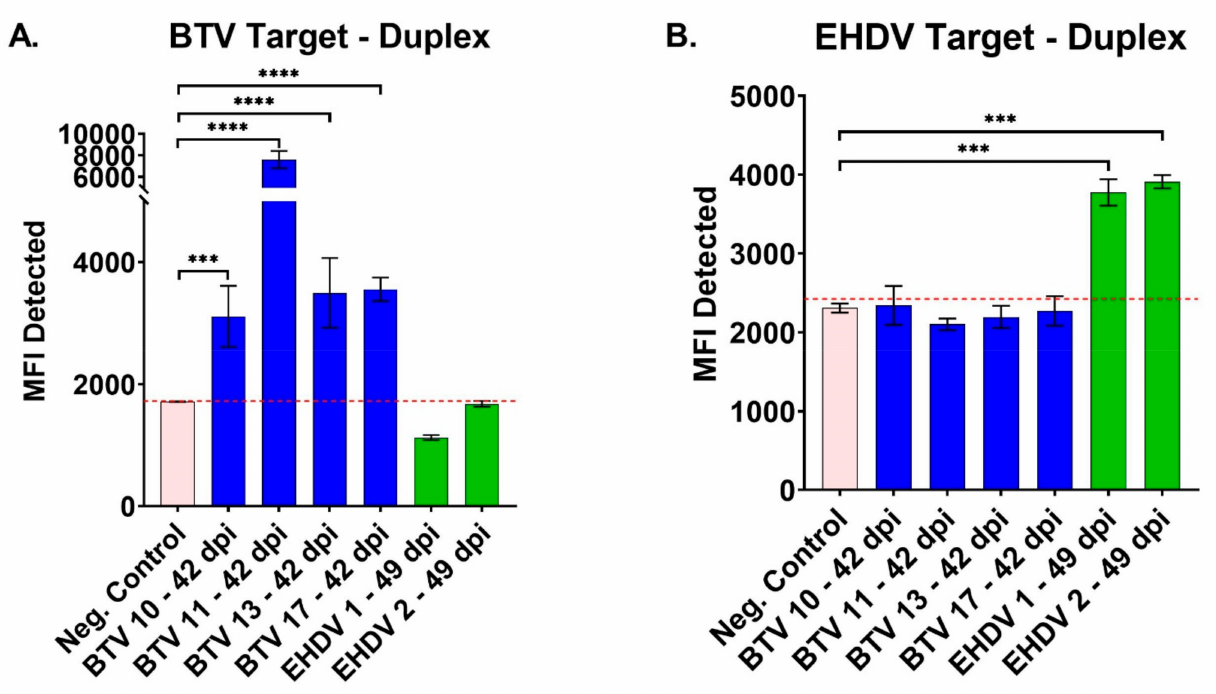
Figure 3. Mean fluorescence intensity (MFI) values of the BTV/EHDV duplex FMIA for simultaneous, differential detection of antibody to multiple BTV and EHDV serotypes. ( A ) MFI values for the BTV-target microbead with sera from cattle experimentally infected with BTV-10, -11, -13, -17 or EHDV-1 or -2, compared to commercial negative control sera. ( B ) MFI values for the same negative control and experimental sera against the EHDV-target microbead. Two-way ANOVA with Dunnett’s multiple comparisons test and standard error; *** p < 0.001, **** p < 0.0001. Receiver operating characteristic (ROC) analysis followed by a Youden’s J Index was used to inform test cutoff value (red line) within the sera tested (BTV-target = 1724.43; EHDV-target =